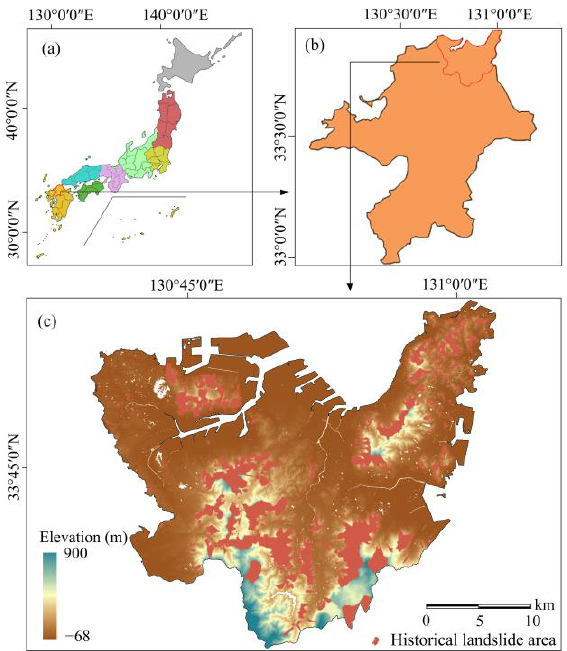
Figure 3. Location map of the study area showing: ( a ) Japan; ( b ) Fukuoka; and ( c ) Kitakyushu.